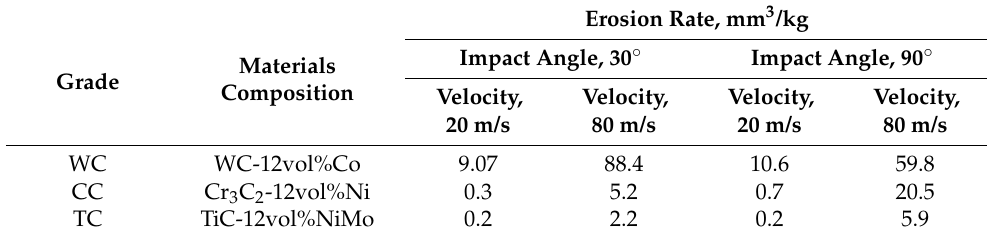
Table 4. Erosion rate of carbide composites at 600 ◦ C